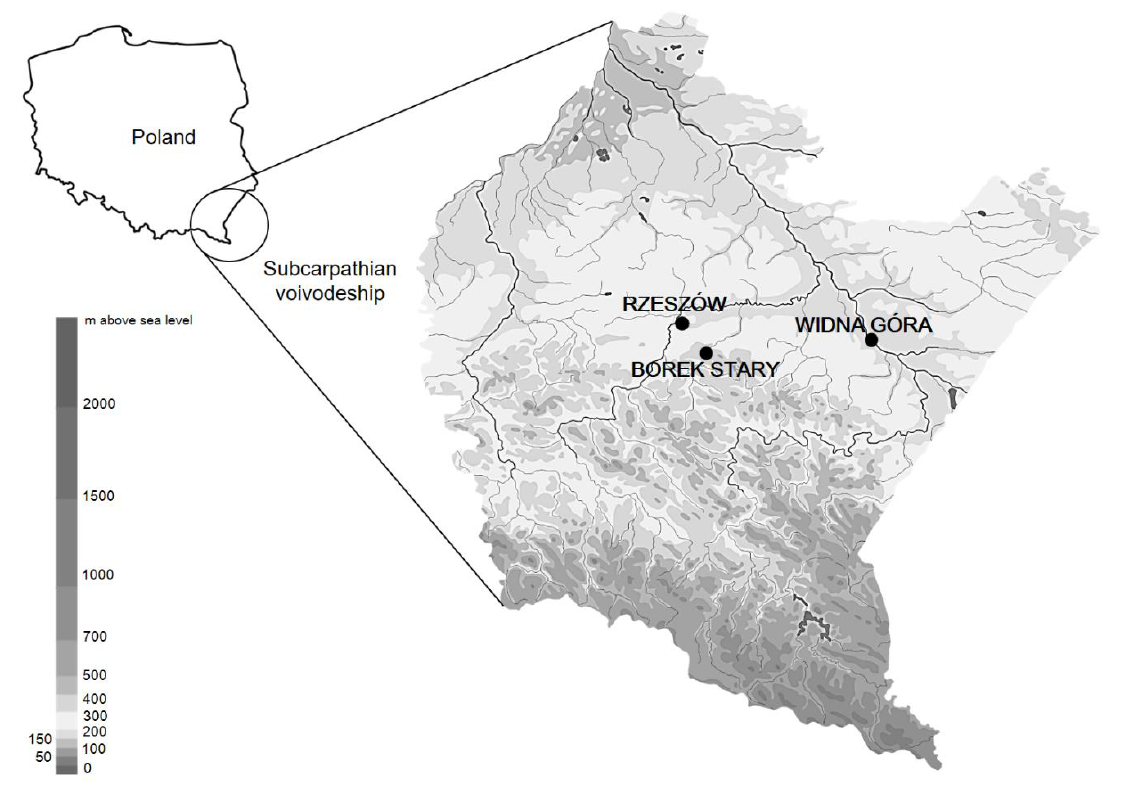
Figure 1. Location of research stands (Own work out based on https://upload.wikimedia.org/wikipedia/commons/6/6e/Podkarpackie_mapa_fizyczna.png).